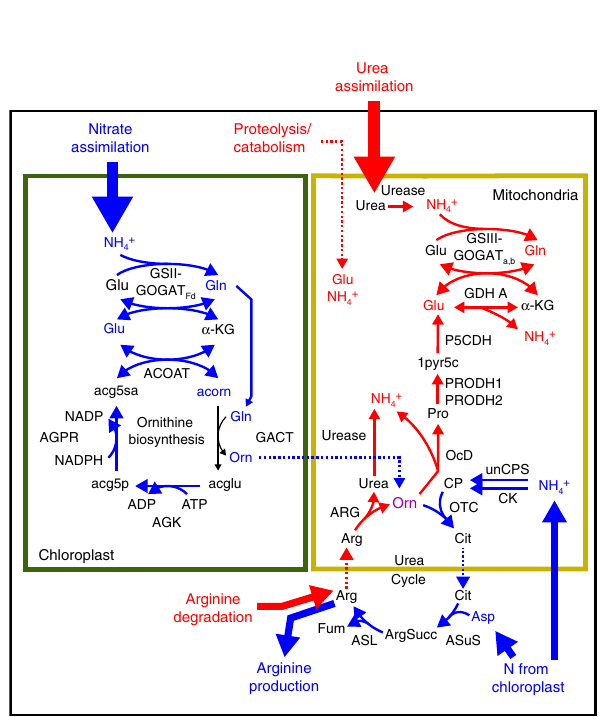
Fig. 6 Con fi guration of organellar GS-GOGAT cycles and split-organelle arginine biosynthesis. Pathway diagram of chloroplast nitrate assimilation and mitochondrial urea assimilation. Pathways are colored to indicate Gene name abbreviations can be found in Supplementary Data